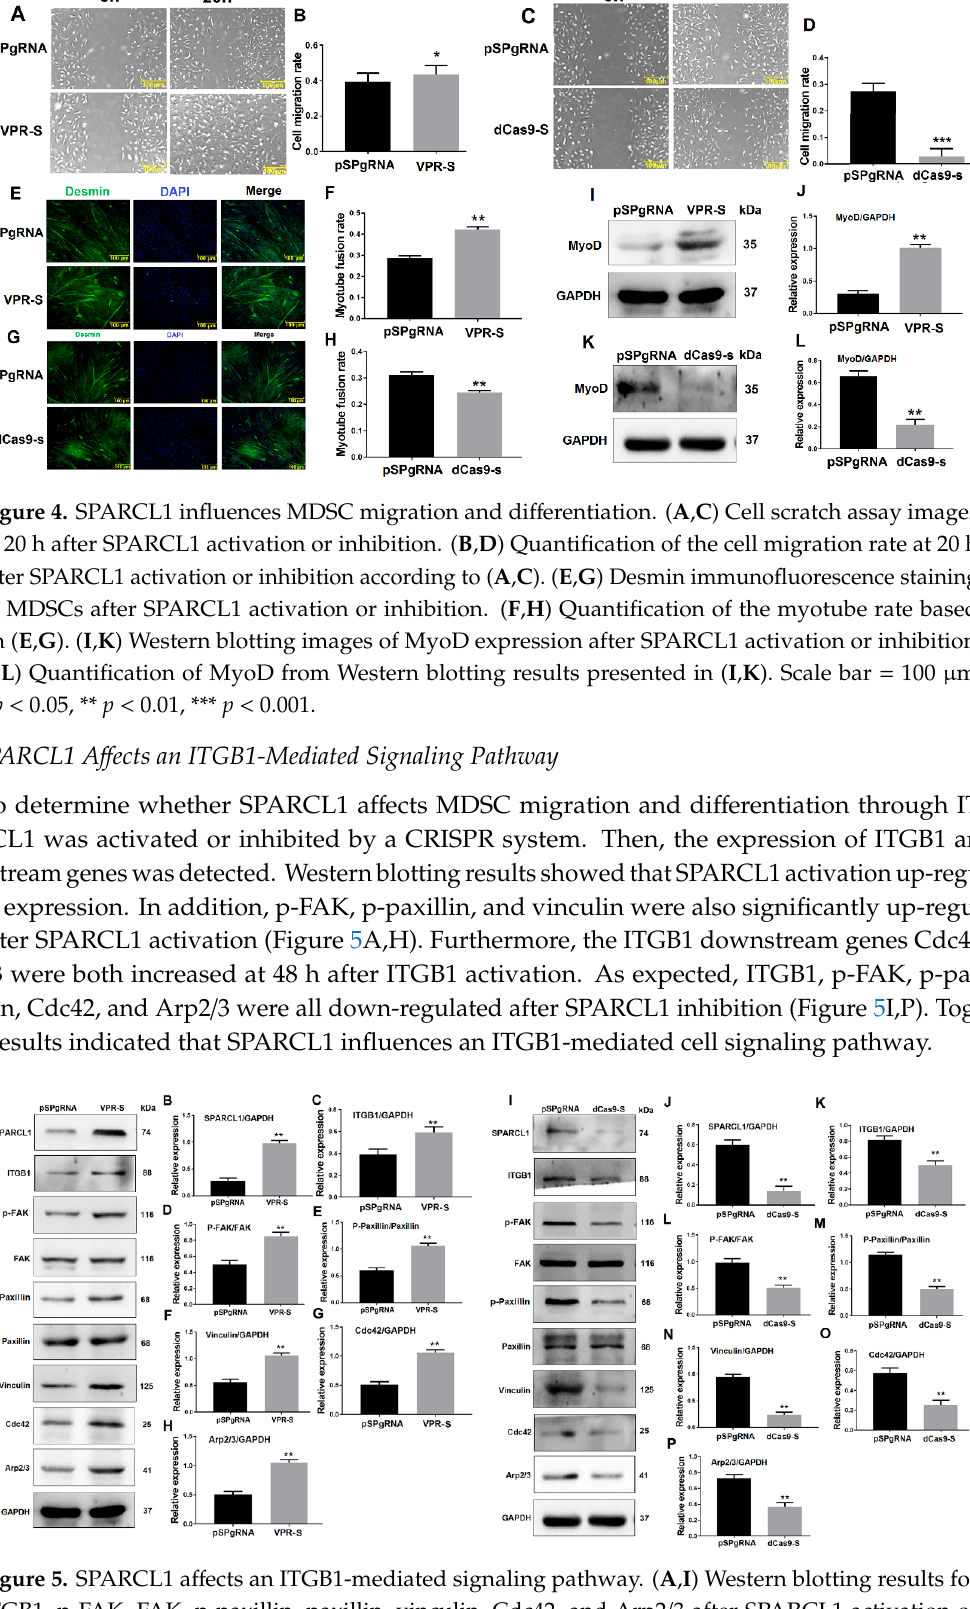
Figure 5. SPARCL1 affects an ITGB1-mediated signaling pathway. ( A , I ) Western blotting results for ITGB1, p-FAK, FAK, p-paxillin, paxillin, vinculin, Cdc42, and Arp2 / 3 after SPARCL1 activation or inhibition, respectively. ( B – H ) Quantification of the Western blotting results presented in ( A ). ( J – P ) Quantification of the Western blotting results presented in ( I ). ** p < 0.01.